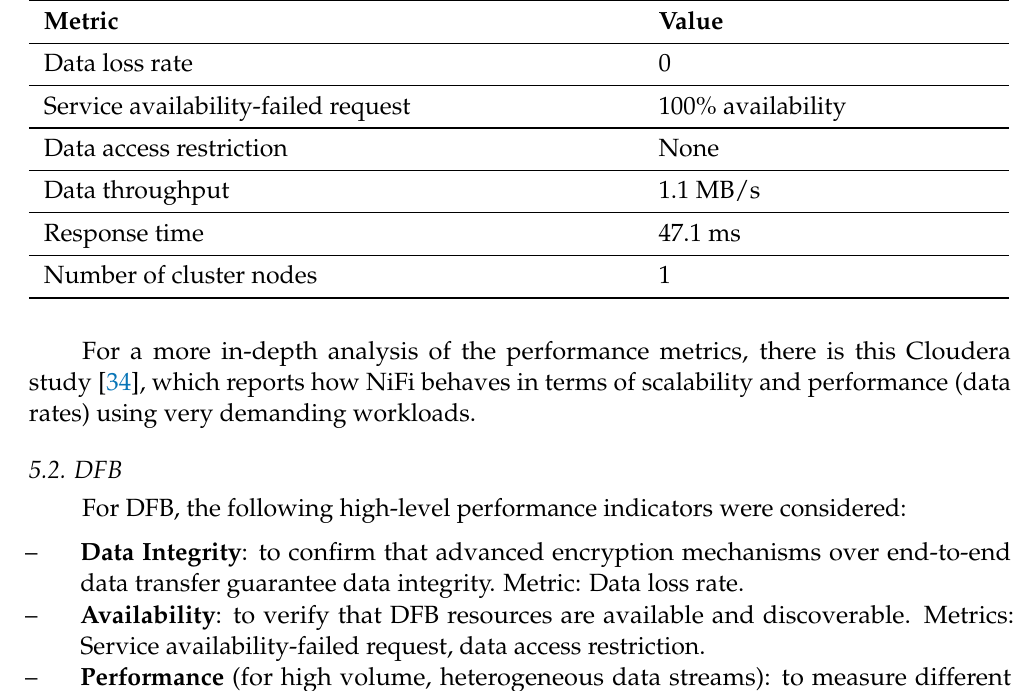
Table 1. Results of the measurements for DatAna component.